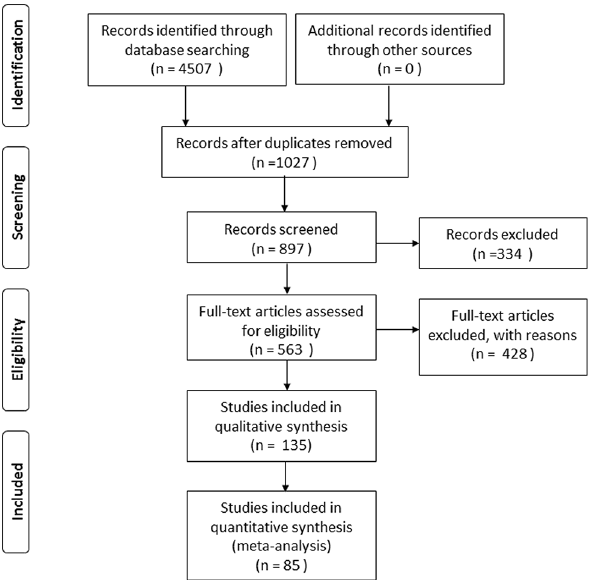
Fig 1. Selection of studies for inclusion in the